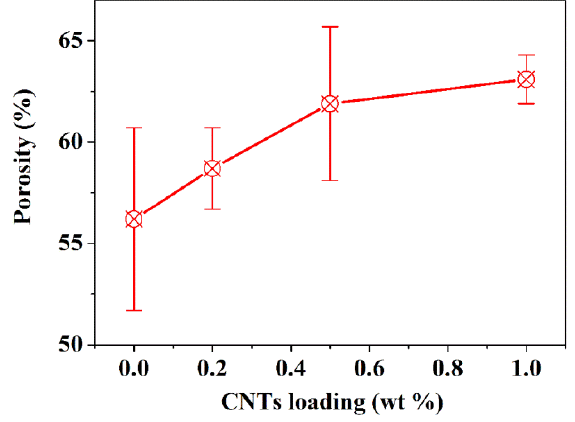
Figure 2. Porosity of alumina/polymer membranes with different CNTs